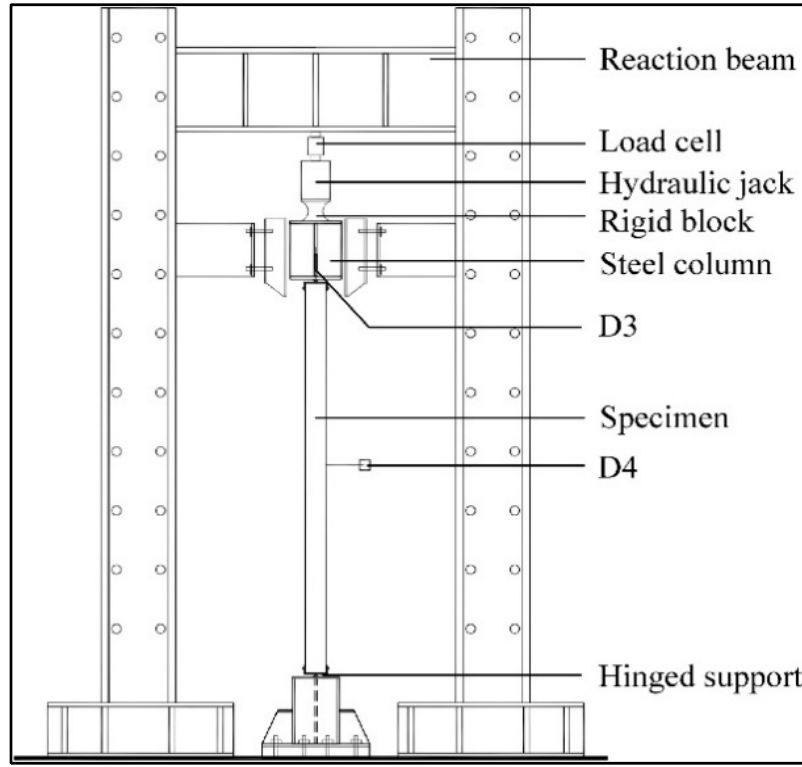
Figure 9. Test setup for residual compressive load-carrying capacity test [168].